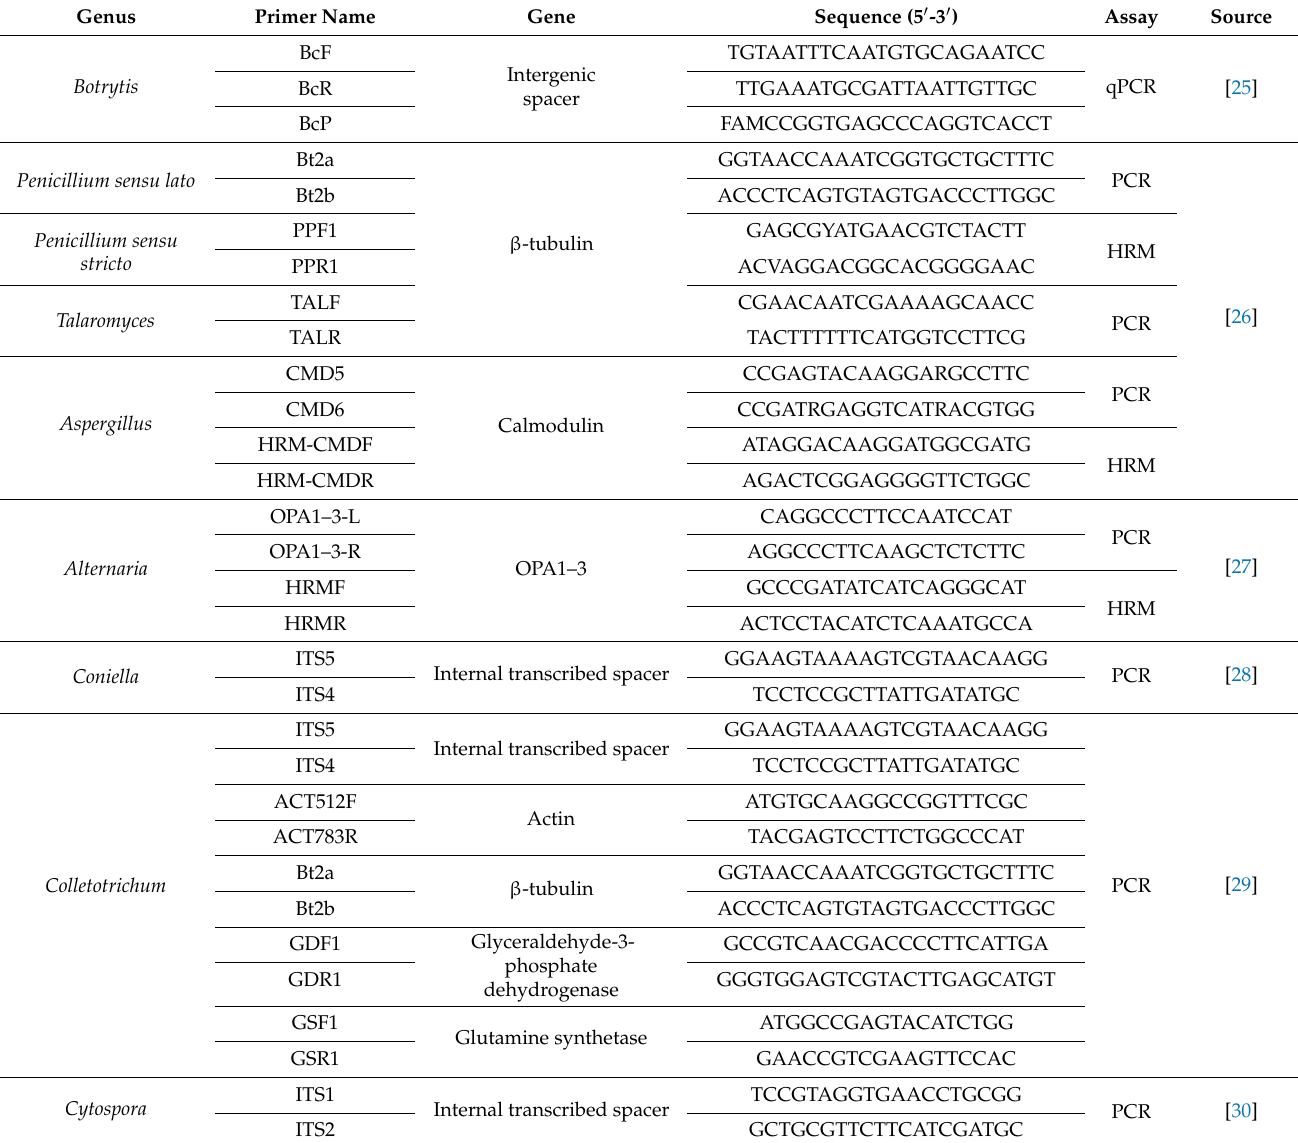
Table 1. Pomegranate pathogens, primer name, target region, primer sequence, type of assay, and reference for their